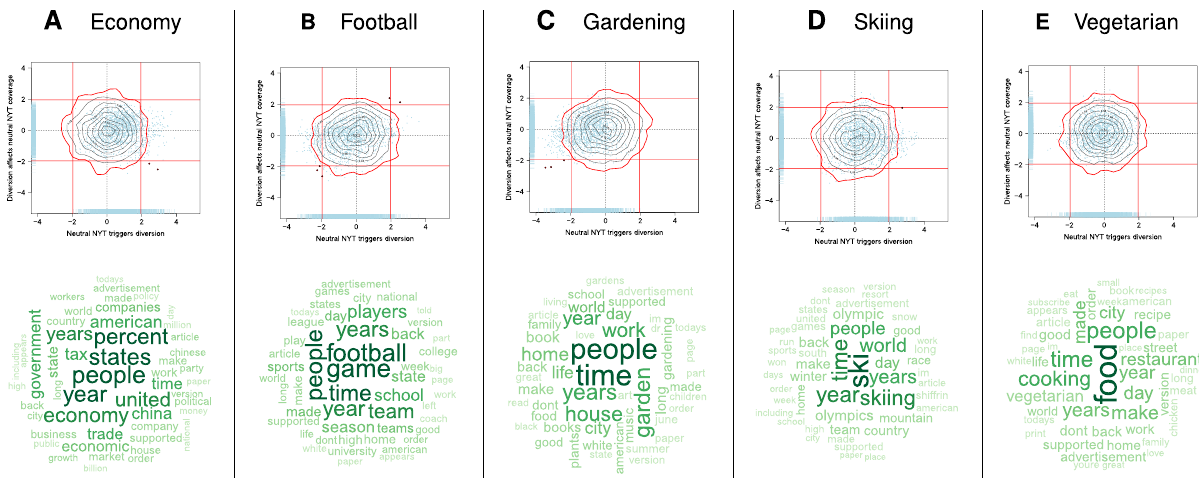
Fig. 7 Analysis of placebo keywords. Top row of panels shows the results of the expanded analysis using two independent OLS models for the placebo keywords “ economy ” (panel ( a )); “ football ” ( b ); “ gardening ” ( c ); “ skiiing ” ( d ); and “ vegetarian ” ( e ). In each panel, the axes show jittered t -values of the regression coef fi cients for diversion (X-axis) and suppression (Y-axis). Each point represents diversion and suppression for one pair of words in the Twitter vocabulary. Red vertical and horizontal lines denote signi fi cance thresholds (±1.96). Word pairs that are triggered by coverage of the corresponding keyword ( p < 0.05) and affect subsequent coverage ( p < 0.05) are plotted in red. The gray contour lines in each panel show the distribution of points obtained if the timeline of tweets is randomized (red perimeter represents 95% cutoff, see “ Methods ” ). The blue rugs represent univariate distributions. The word clouds accompanying each plot represent the 50 most frequent words found in the NYT articles selected on the basis of the corresponding